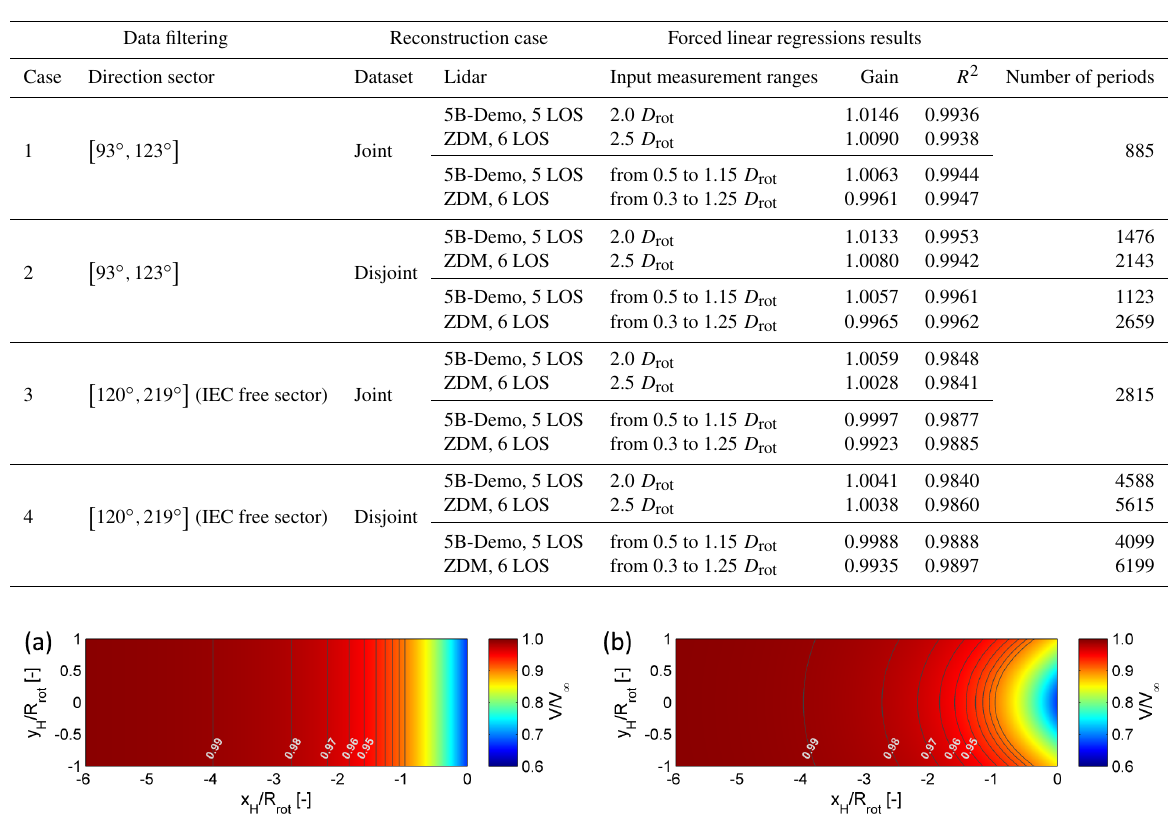
Figure 11. Analytical flow field in the induction zone of a wind turbine, at hub height and with an induction factor a = 0 . 334. (a) One- dimensional model (Eq. 10). (b) Two-dimensional